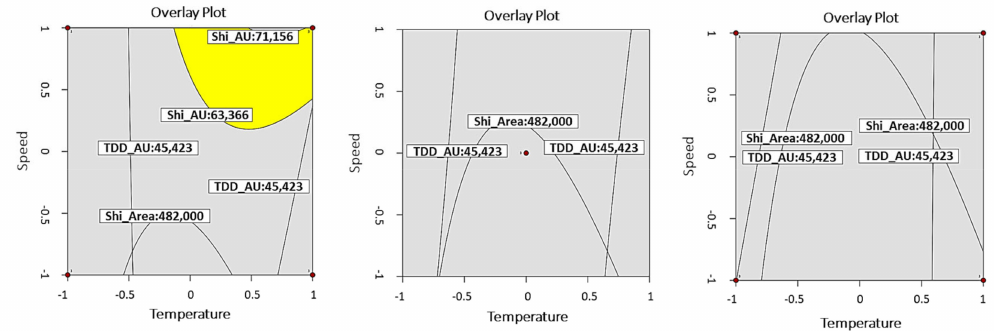
Figure 5. Contour plot with X2 (circulation velocity) fixed at –1, 0, + 1 levels.